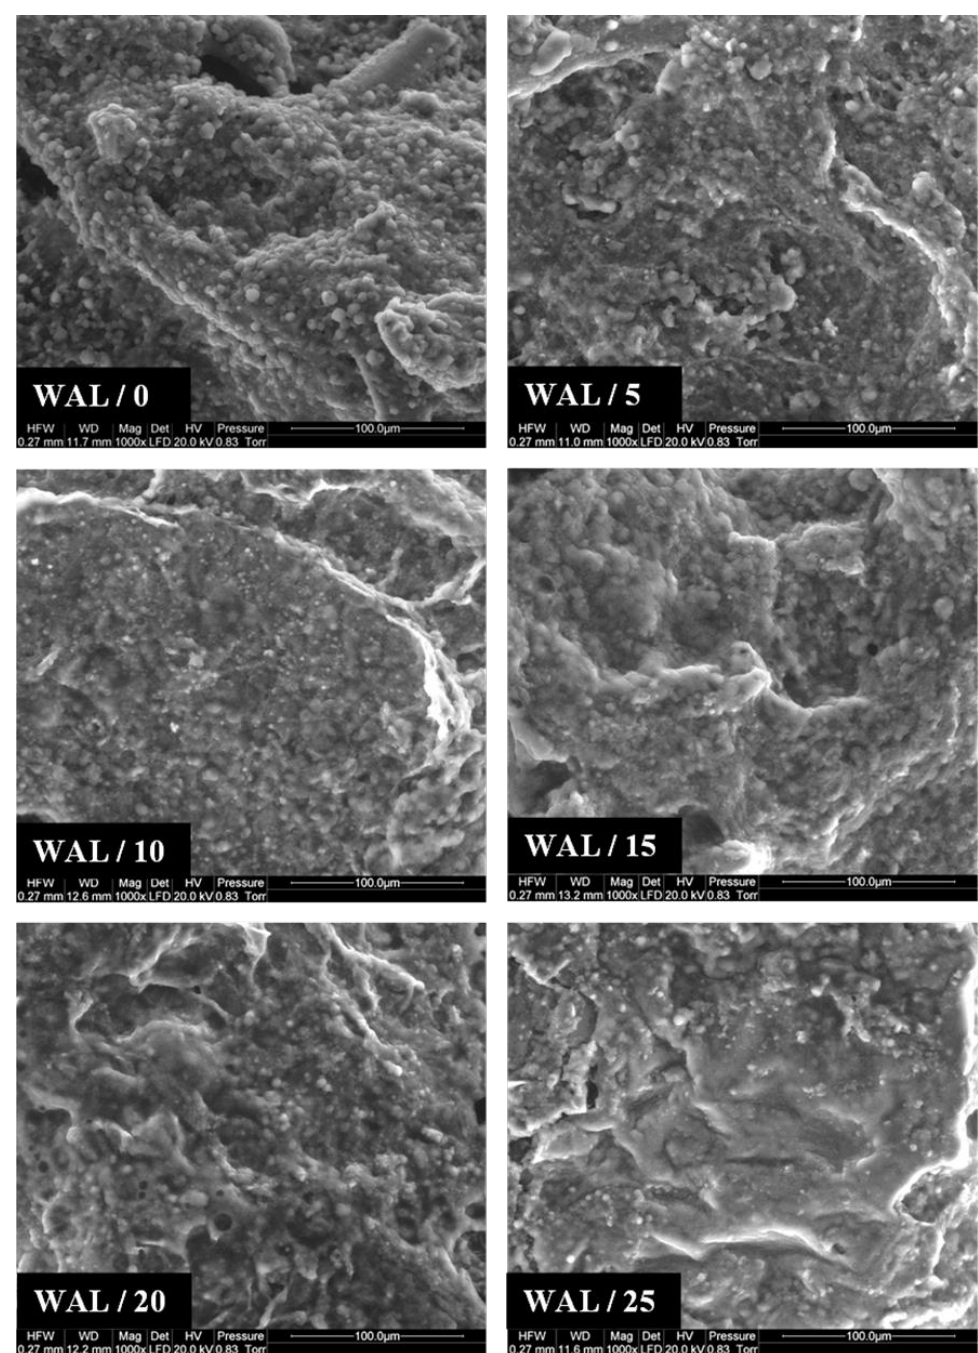
Figure 3. Selected scanning electron micrographs of the liver sausages.